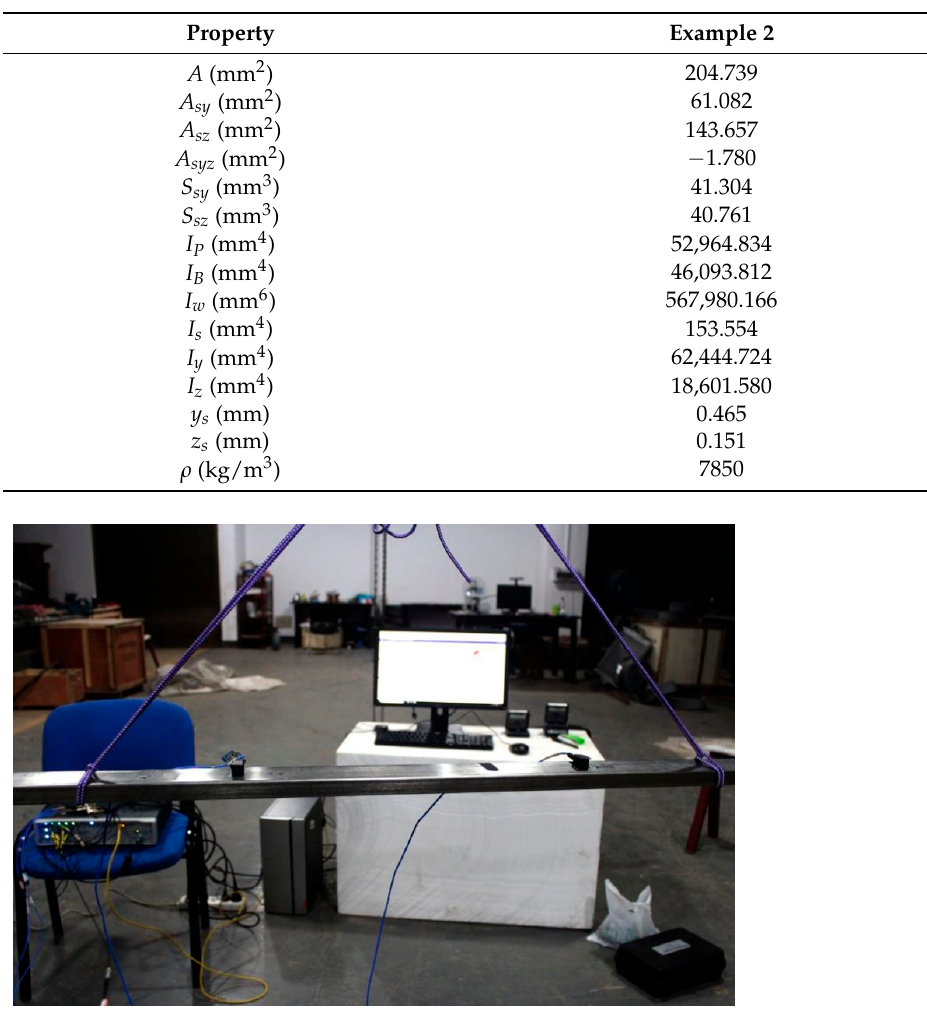
Figure 9. Experimental setup and instrumentation.